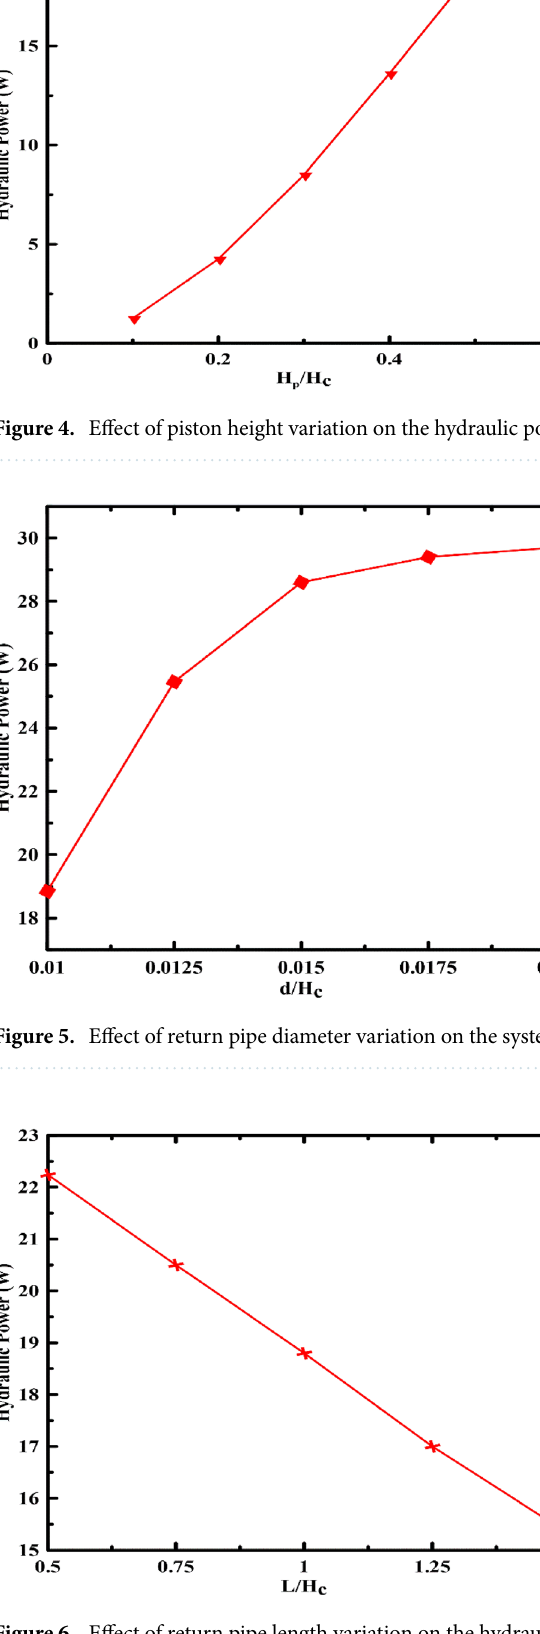
Figure 6. Effect of return pipe length variation on the hydraulic